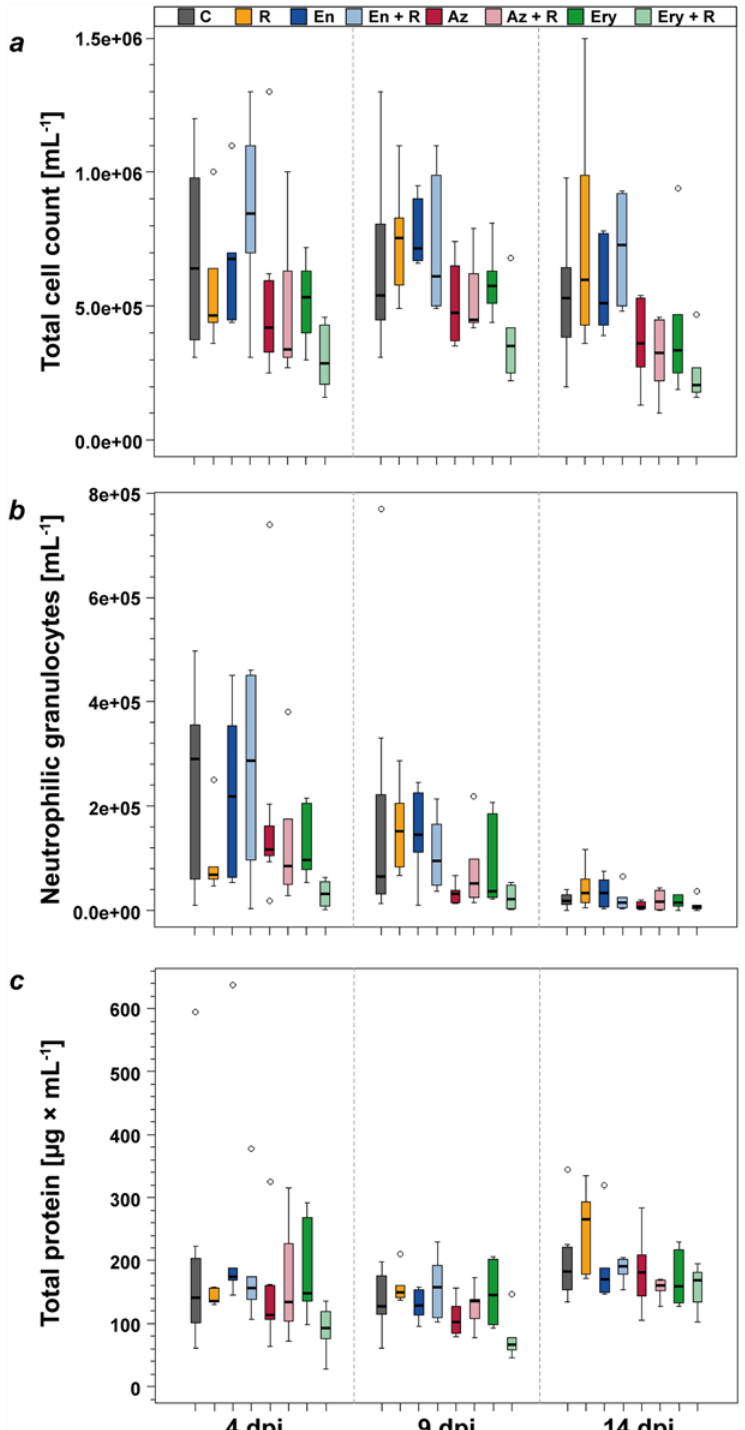
Fig 5. Bronchoalveolar Lavage Fluid (BALF). In the BALF, total cell count (a) remained within comparable limits at all examined time points in all groups. Numbers of neutrophilic granulocytes per mL (b) were highest 4 dpi and dropped continually until the last day of the study. Total protein concentration in BALF-supernatant remained constant throughout the whole study. Statistically significant differences between treated and untreated animals could neither be detected for protein levels nor for numbers of cells or neutrophils per mL